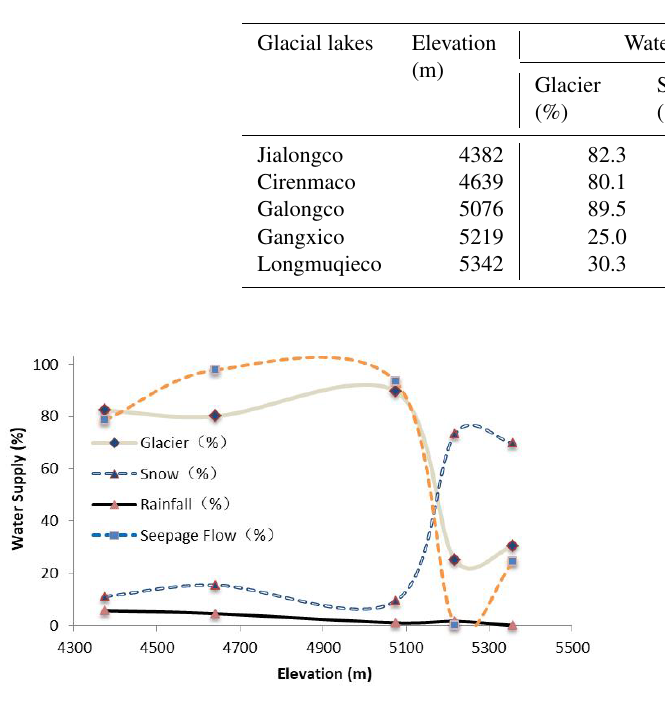
Table 13. Fractions of various water supplies to the lakes.